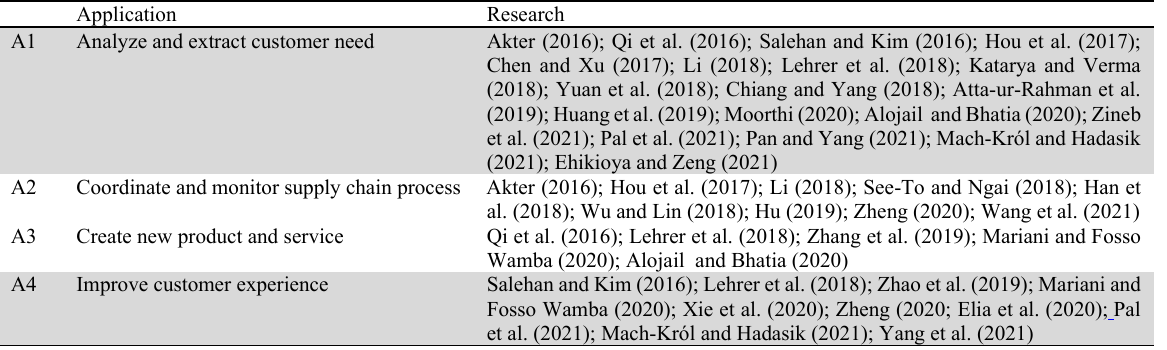
Big data applications in